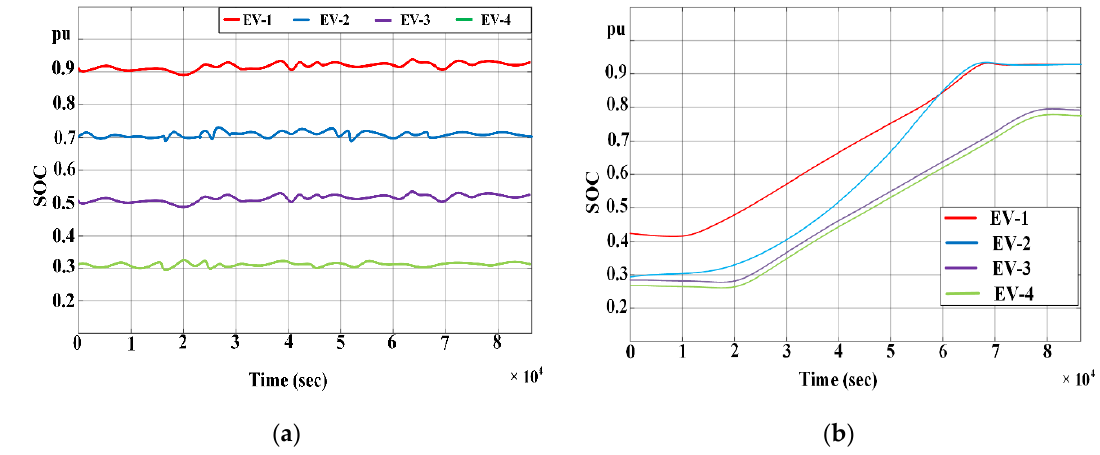
Figure 12. Real-time battery state of charge for the four EVs under consideration for ( a ) TYPE 1, Charging Station 1 and ( b ) TYPE 2, Charging Station 1.